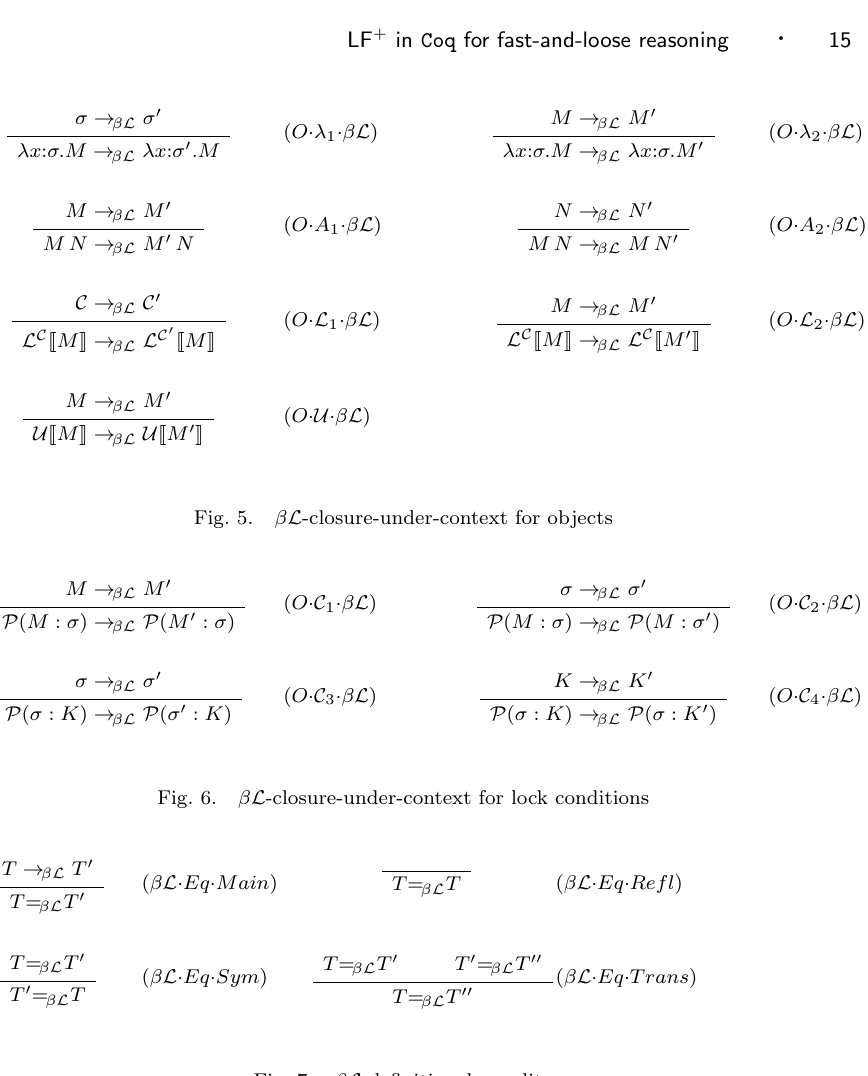
Fig. 7. β L -definitional